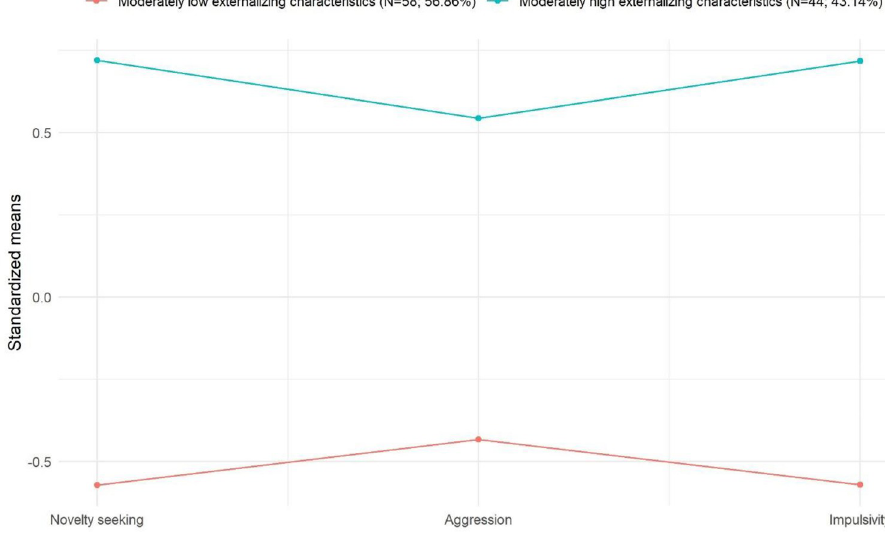
Fig 1. Profile characteristics of the latent classes. All indicator variables are standardized in order to facilitate understanding of class-based characteristics. Therefore, each indicator variable’s mean equals 0 and standard deviations equal